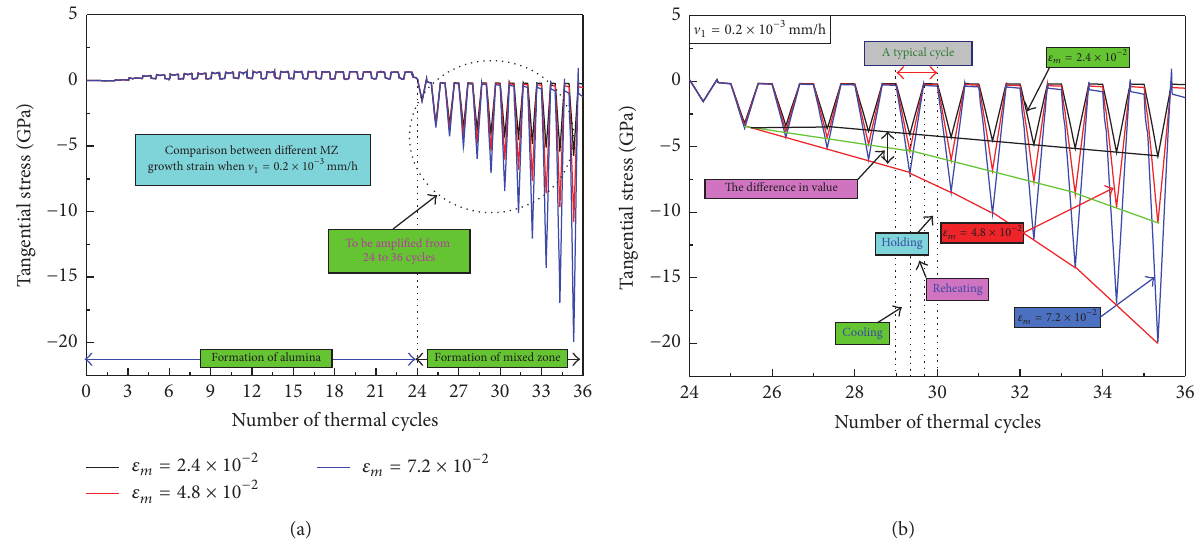
Figure 10: (a) The variation of the tangential stress at element number 20857 at the base of the surface groove against the number of thermal cycles when V 1 = 0.2 × 10 −3 mm/h. (b) The details for the variation of tangential stress for the first two thermal cycles.